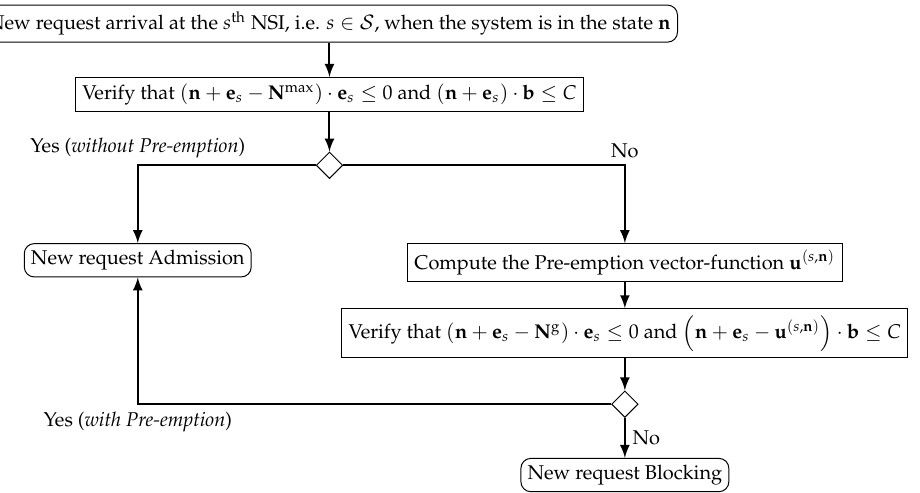
Figure 1. Flowchart formalizing the RAC scheme for accessing the s th NSI, i.e., s ∈ S , at the 5G